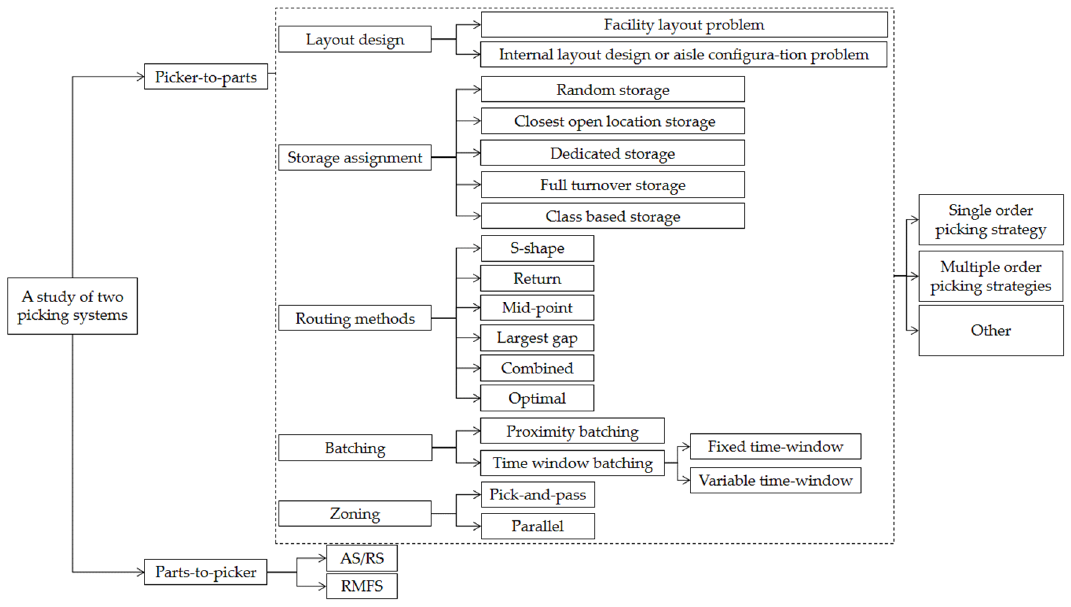
Figure 5. Research framework.